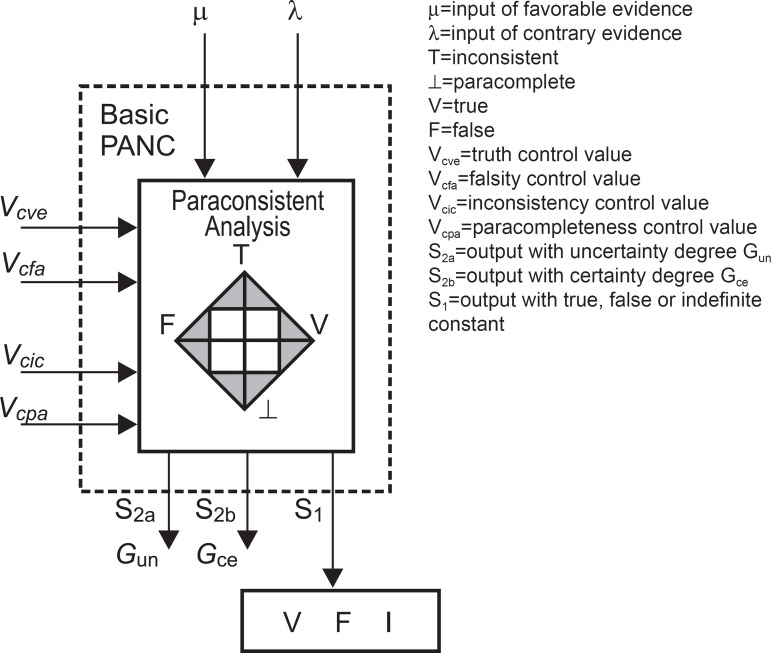
Basic cell of PANN.The resulting certainty degree Gce is obtained as follows:If: Vcfa ≤ Gun ≤ Vcve or
Vcic ≤ Gun ≤ Vcpa ⇒
Gce = IndefinitionFor: Vcpa ≤ Gun ≤ VcicIf: Gun ≤ Vcfa ⇒ Gce = False with degree
GunVcic ≤ Gun ⇒ Gce = True with degree
GunA Paraconsistent Artificial Neural Cell – PANC – is called basic PANC when a
given pair (µ, λ) is used as input, and resulting as output:
Gun=resulting uncertainty degree, Gce=resulting
certainty degree, and X=constant of Indefinition.